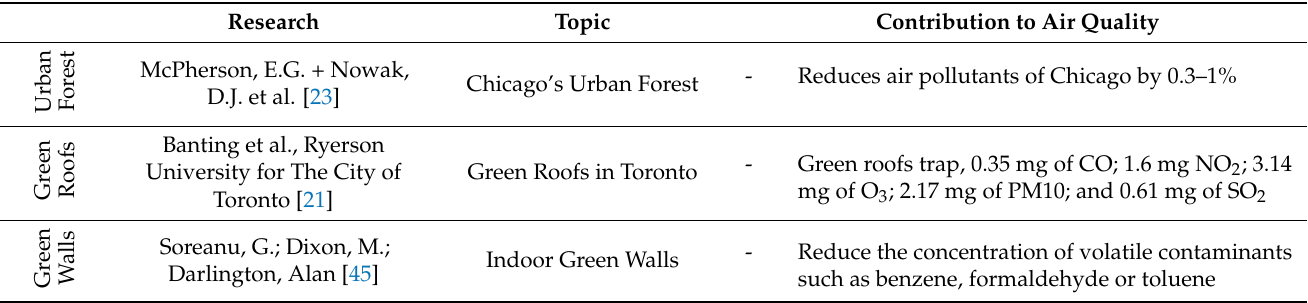
Table A4. Summary table of air quality (developed by the authors).